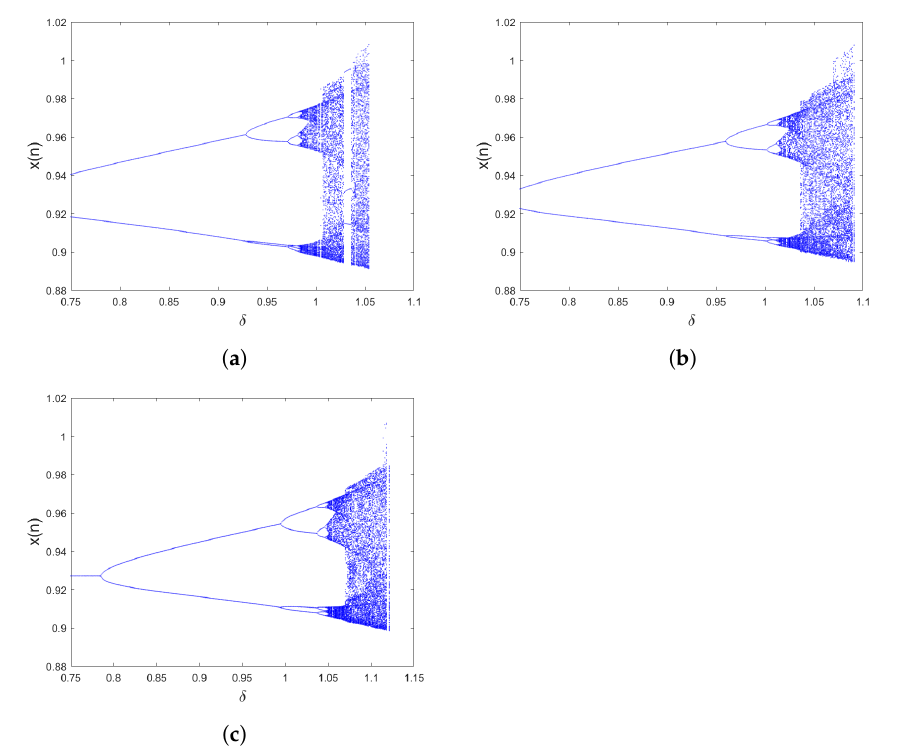
Figure 3. Bifurcation diagrams of (3) versus δ for ( a ) γ = 0.7, ( b ) γ = 0.78, ( c ) γ =